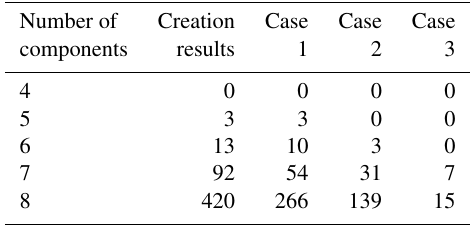
Table 1. Creation results of the DPGT transplanting mechanism. Number Total number Suitable Results of the of of DPGTs for available literature components transplanting